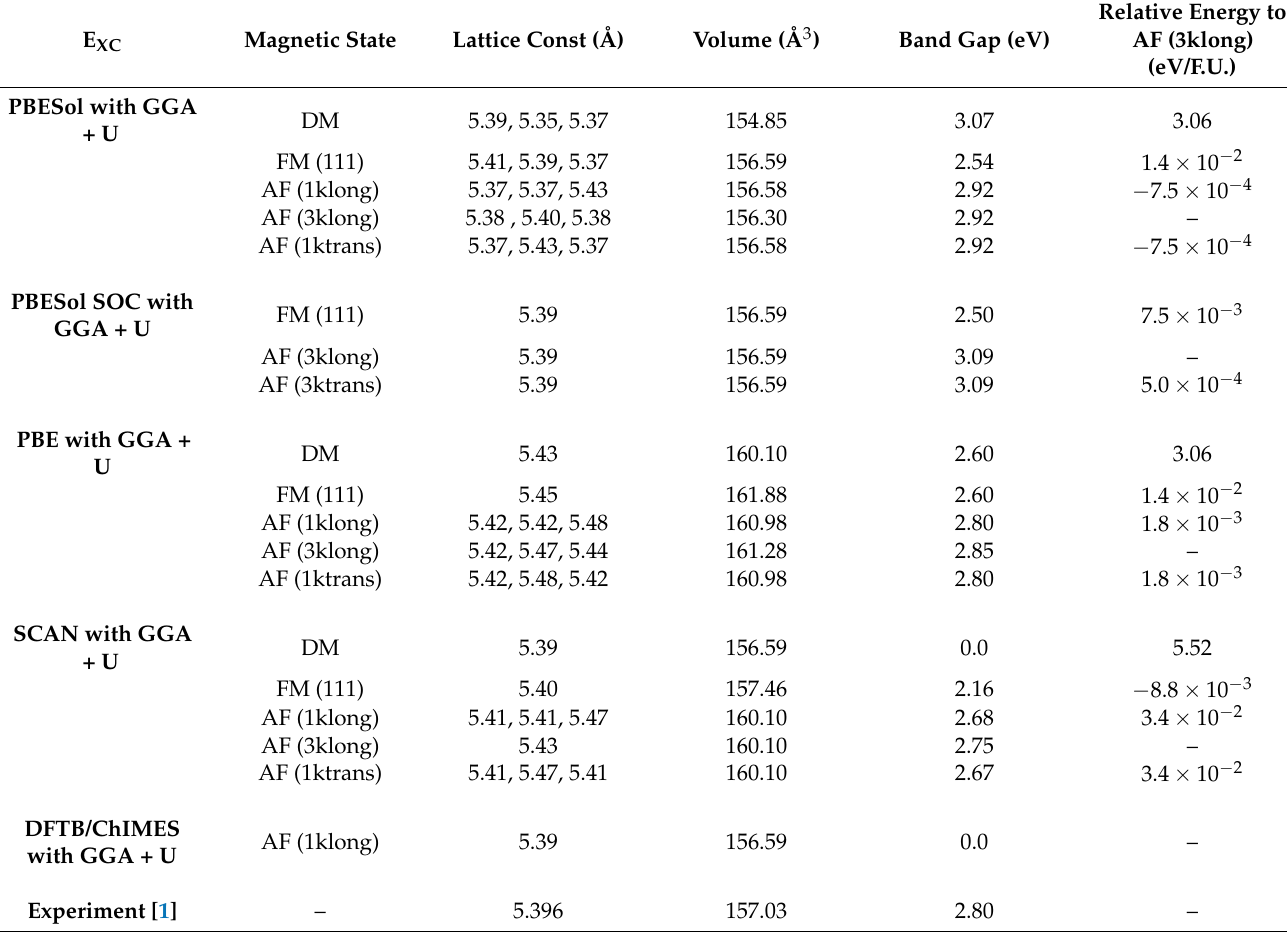
Table 2. Physical properties of bulk PuO 2 as a function of DFT functional and magnetic state. All DFT results reported here include GGA + U with U eff = 6.00 eV. Calculations were performed with SP, excluding those denoted with SOC. Listing of a single lattice constant value corresponds to optimization to a cubic lattice within an error of 0.01 Å per lattice length. The DFTB/ChIMES result was computed with U eff = 4.08 eV in order to yield an accurate lattice